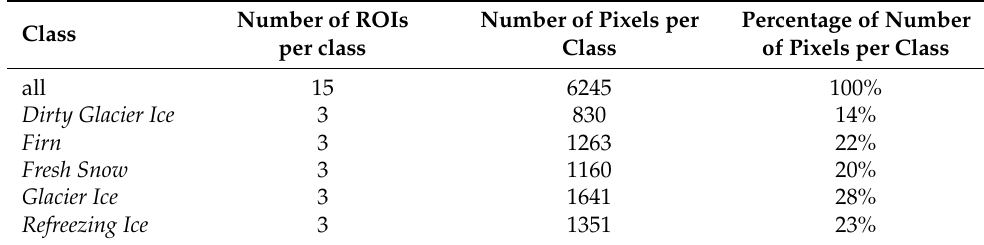
Figure 6. Spatial distribution of the Training Areas (TAs) and the Control Areas (CAs) on the subset S . The color encoding follows Figure 3 and accounts for the classes Glacier Ice (red), Refreezing Ice (green), Dirty Glacier Ice (blue), Firn (cyan), and Fresh Snow (yellow). Table 1. Characteristics of the training data in terms of the number of areas (ROIs) and number of pixels per class.